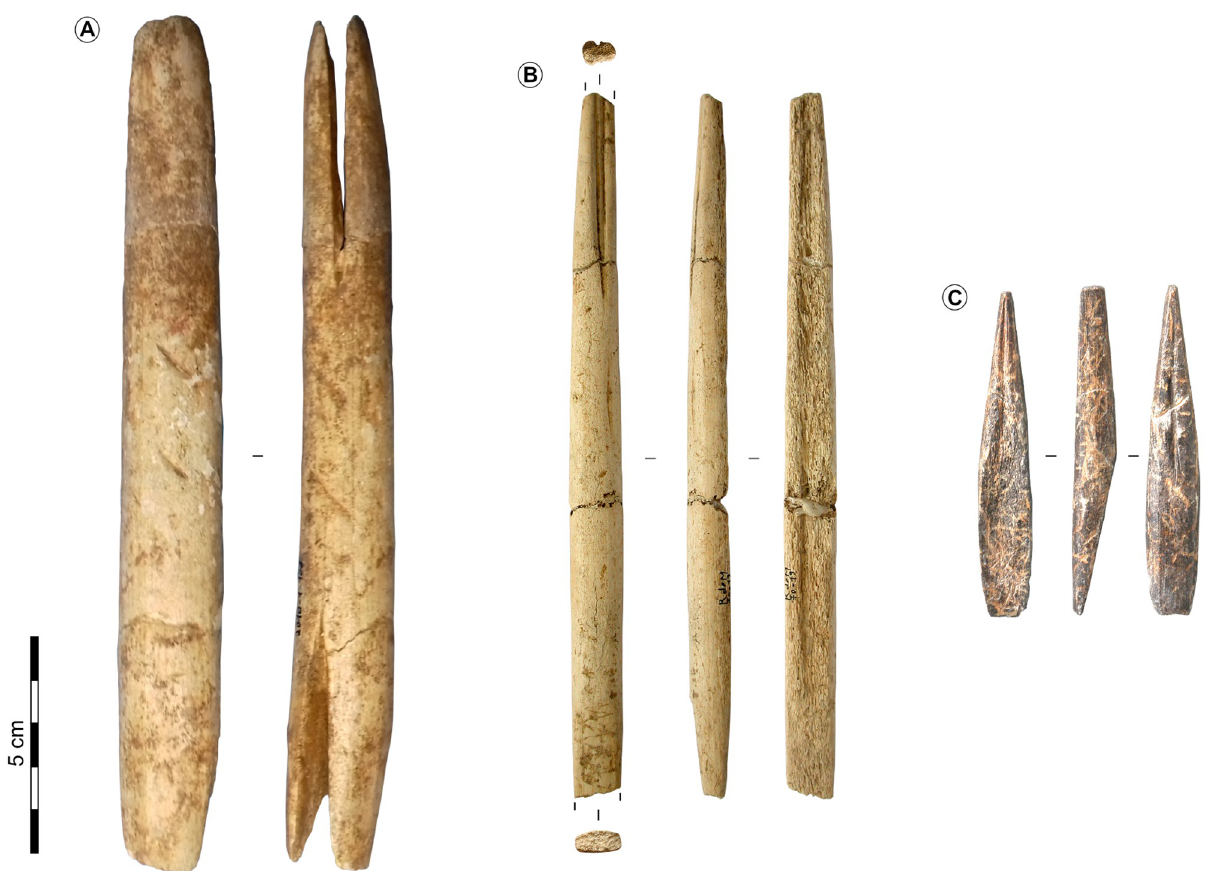
Fig 3. Typical osseous artefacts of the tradition with navettes (A, B) and with Lussac-Angles (C). A-Navette from the Blanchard cave n˚2010.1.106, layer B4, credits: A. Dessolier, Muse´e d’Argentomagus. B-Double-bevelled point from the Roc-de-Marcamps, Maziaud collection, credits: Pe´tillon, 2016. C-Lussac-Angles point from La Marche, credits: J.